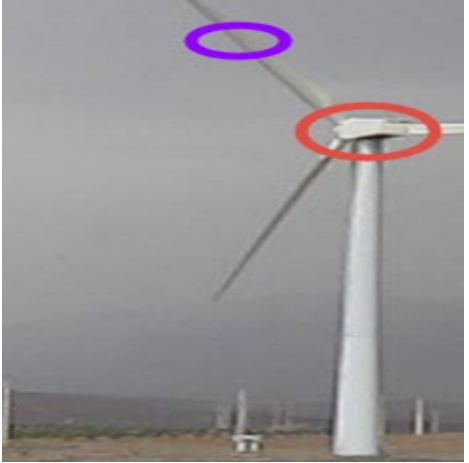
Figure 3. The hub and a part of one blade in a sample wind turbine tower